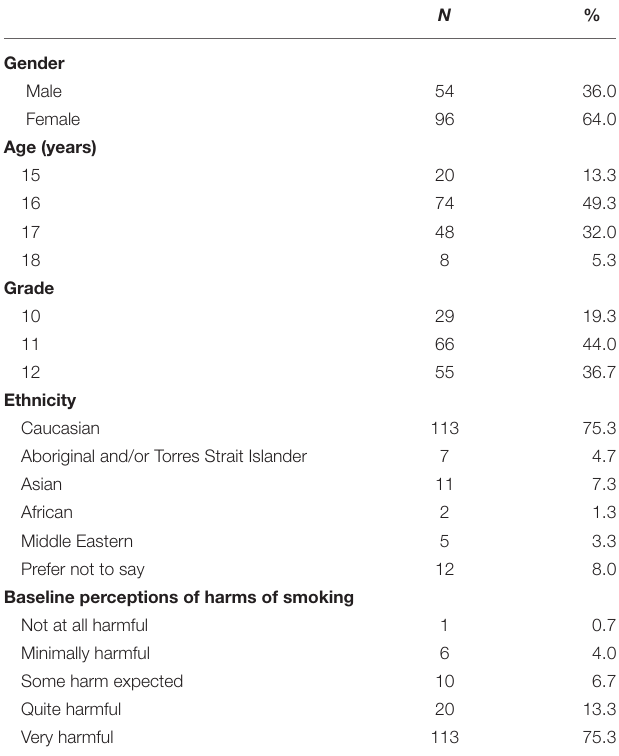
TABLE 1 | Demographic characteristics and baseline perceptions of survey